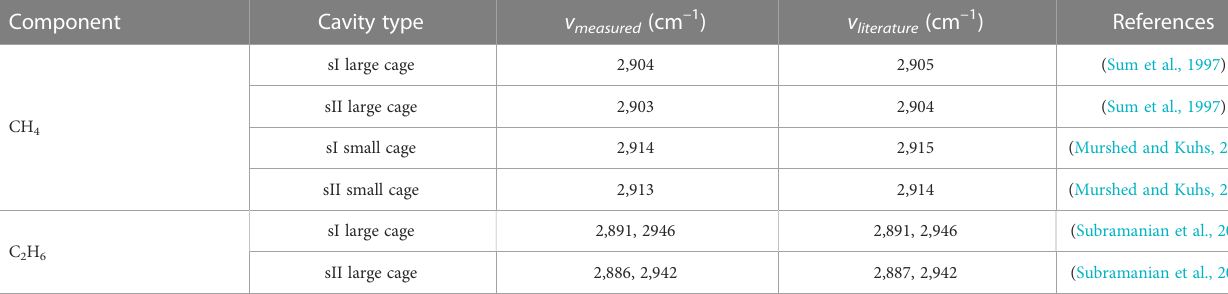
TABLE 2 Assigned and measured Raman shifts in different hydrates based on literature data. Component